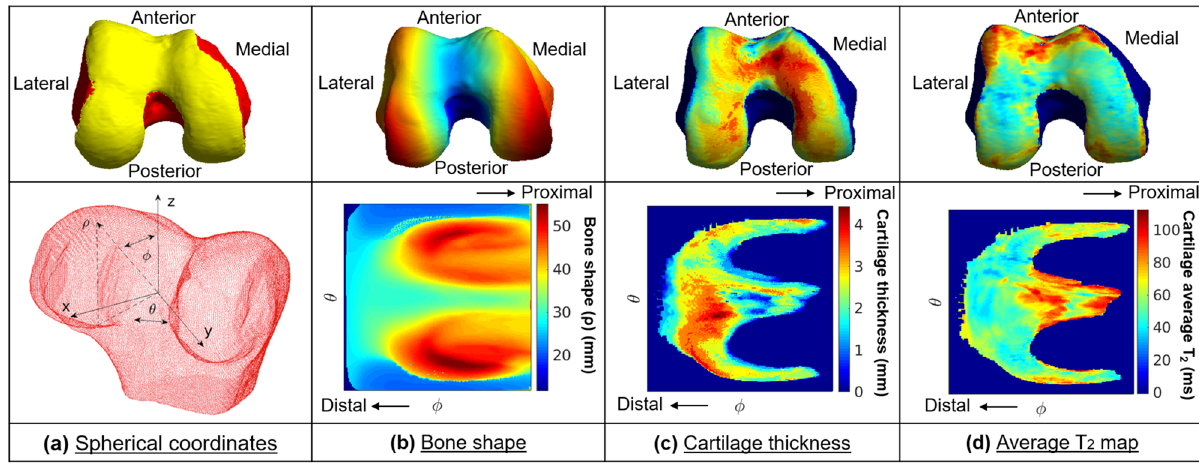
Figure 3. Biomarker 2D spherical maps. The three biomarkers projected to the articular bone surface were converted to 2D spherical maps. (a) The transformation from Cartesian coordinates into spherical coordinates was performed by uniformly sampling 224 × 224 points in the point cloud and describing them based on the angle along the x–y plane from the positive x-axis (θ), the elevation angle from the x–y plane (φ) and the distance from the center of the point cloud to the sampled point in the surface (ρ). The angle θ was sampled from − π to + π for all bones while the angle φ was sampled from − π/2 to + π/8 for the femur and tibia and from − π/2 to + π/8 for the patella. The sampling was designed to be centered around the articular surface to ensure the cartilage would be centered for each bone. (b) Bone shape 2D spherical map. (c) Cartilage thickness 2D spherical map. (d) Cartilage average T 2 value 2D spherical